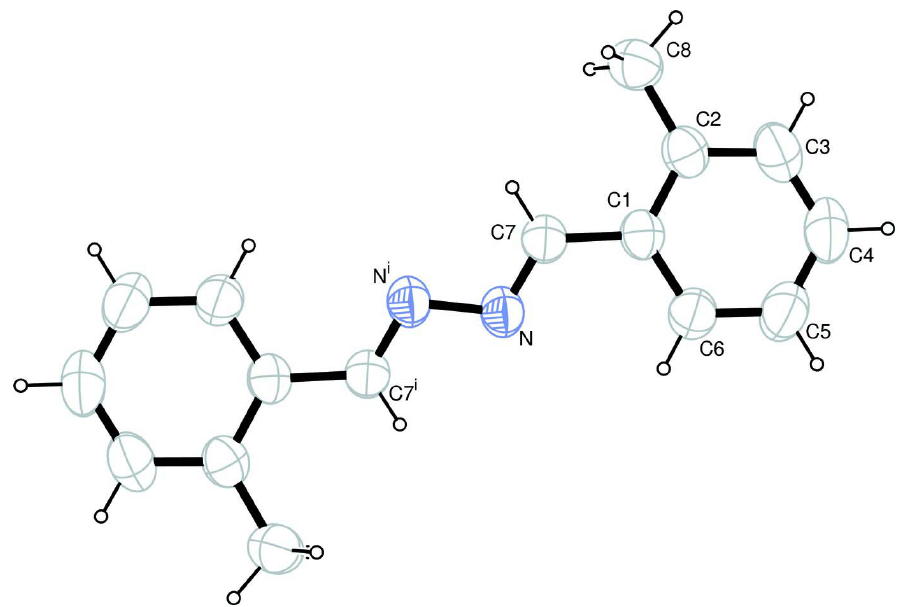
Figure 1 The molecular structure of (I) with 50% probability displacement ellipsoids for non-H atoms. Symmetry code: (i) -x, 1-y,